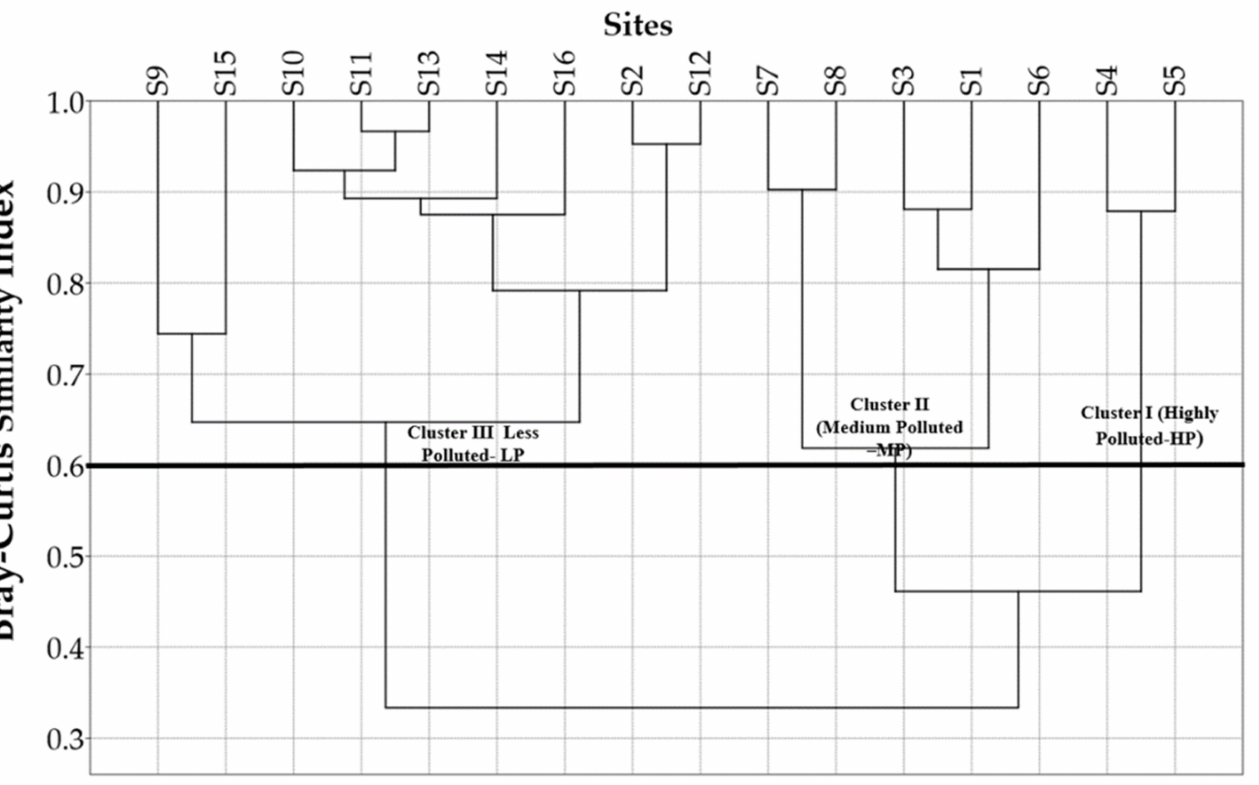
Figure 6. A dendogram showing clustering of sampling sites according to surface water quality characteristics of the Yeongsan River